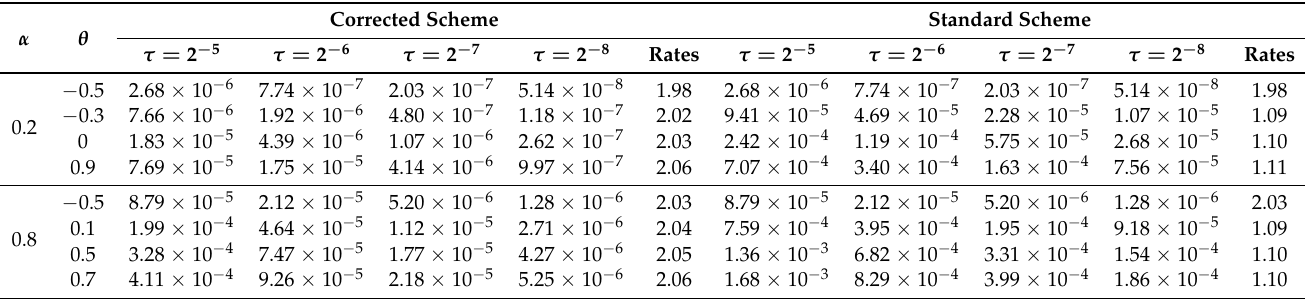
Table 3. L 2 error and convergence rates at time t = 0.5 of Example 2 (ii).